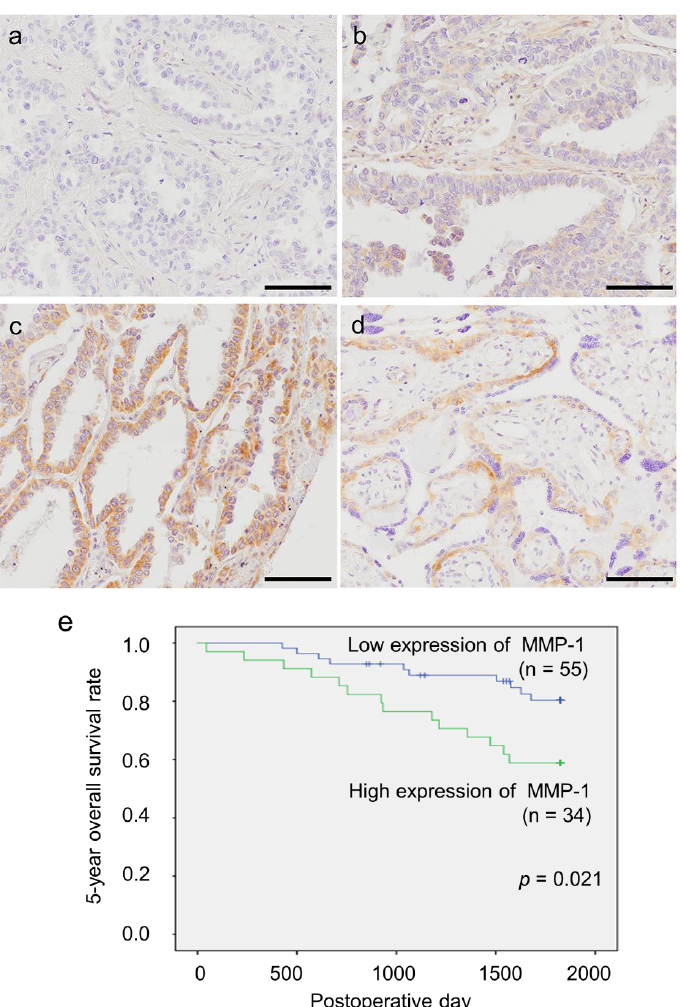
Figure 4. Immunohistochemistry of MMP-1 in patients with lung adenocarcinoma. ( a – d